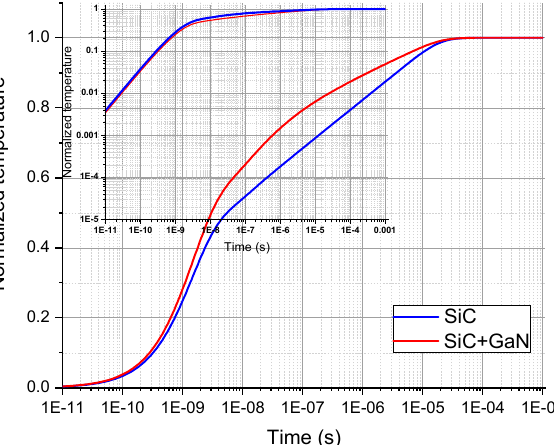
Figure 15. Normalized temperature response versus time (inset log (Temp) versus log (time)).